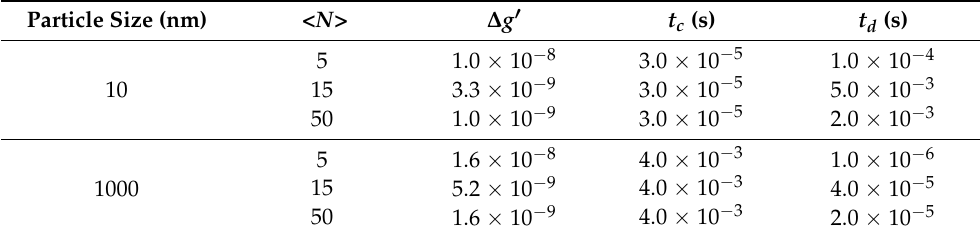
Table 1. The decrease in magnitude, ∆ g (cid:48) , of the number fluctuation term, g (cid:48) ( τ ) , for 10 and 1000 nm particles in the Brownian motion decay time, t c and the delay time, t d , at which the intensity ACFs, ( 2 ) ( τ ) , decay to 0.001 for 10 and 1000 nm particles at (cid:104) N (cid:105) = 5, 15, and 50 particles in the scattering g d volume.